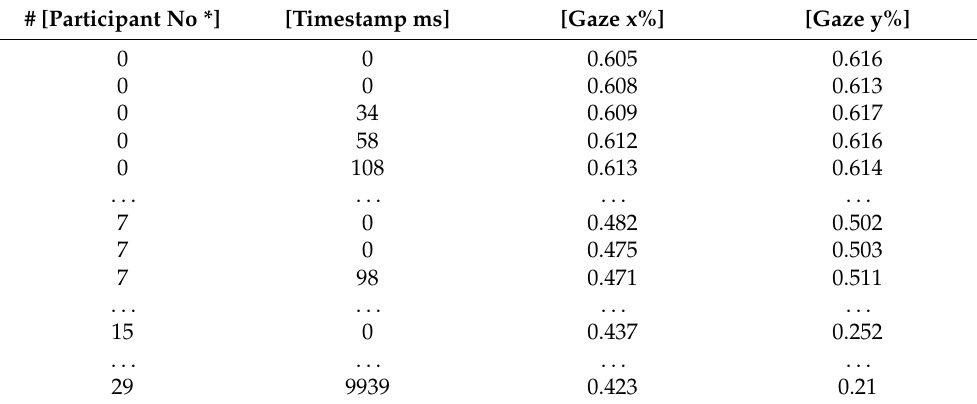
Table 1. The structure of the data